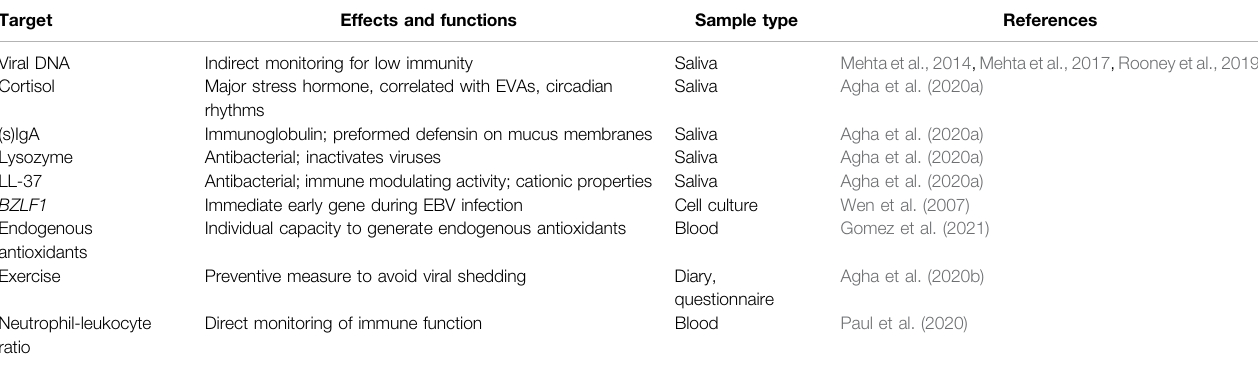
TABLE 1 | Established and potential biomarkers in